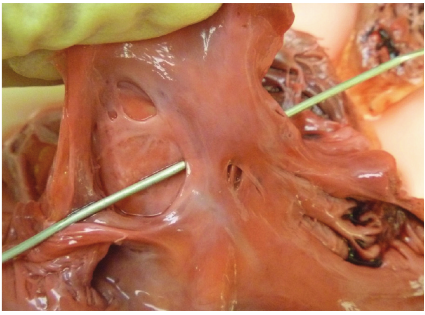
Figure 5: Postmortem photographs illustrating the presence of a patent foramen